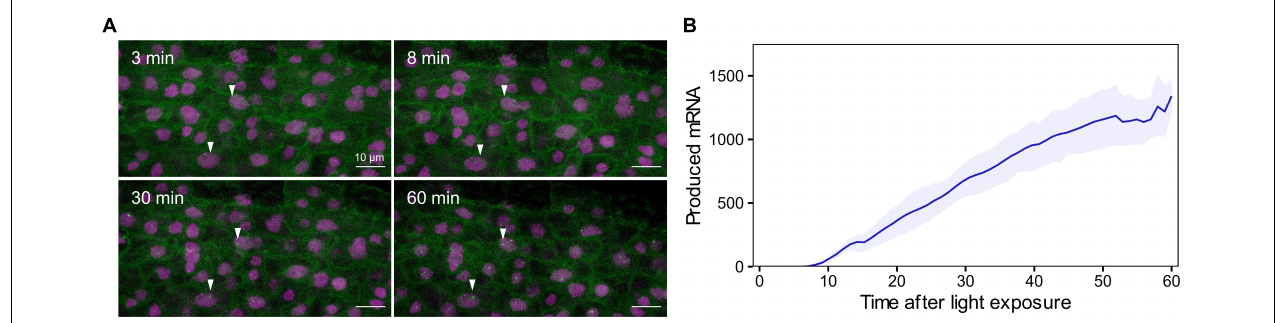
FIGURE 5 | Single cell real-time transcription reveals an earlier start of light-induced RPT2 transcription. (A) Maximum projection snapshots of pRPT2:PP7 plants grown in true-dark conditions for 2 days. The time stamp indicates the time elapsed since the seedlings were exposed to light. Arrowheads point to the appearance of transcription spots. (B) Mean produced mRNA calculated as the integrated spot fluorescence over time. The colored line represents the average mRNA level and the shaded band represents the standard error of the mean. Data obtained from 2 to 5 technical replicates of four independent pRPT2:PP7 transgenic lines are represented.